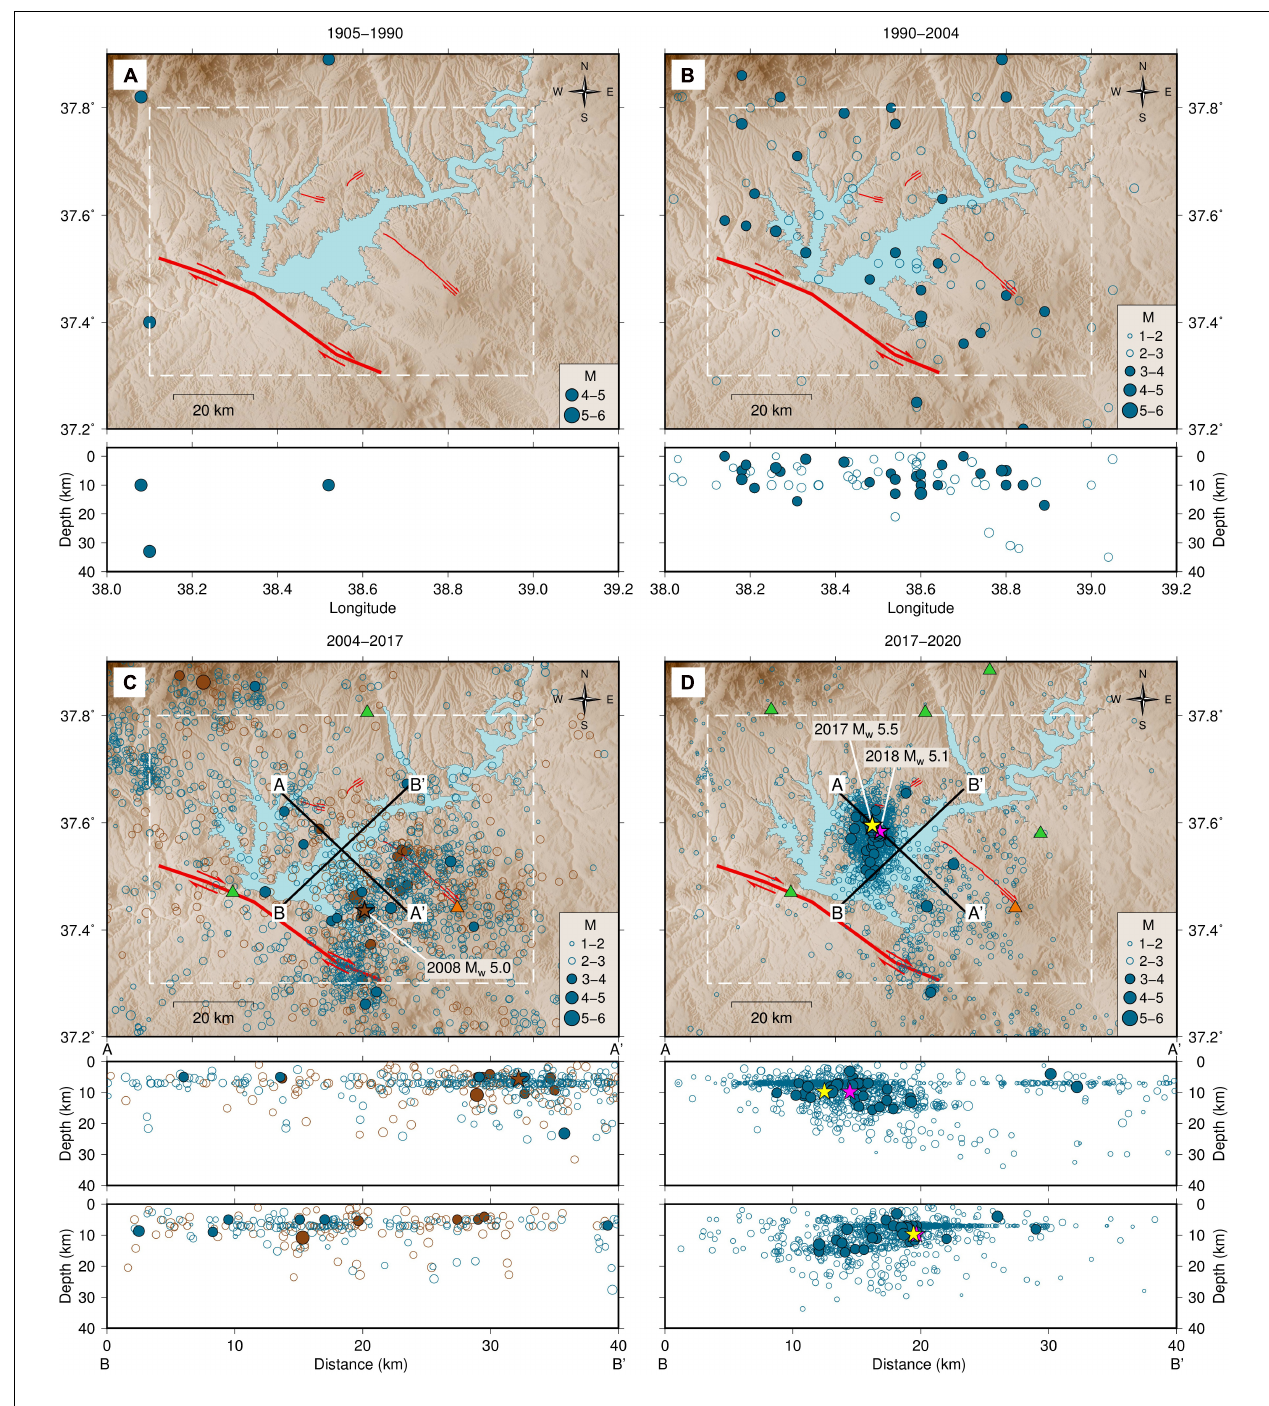
FIGURE 2 | (A–D) Long term (1905–2020) spatio-temporal evolution of recorded earthquakes with their magnitudes and depth cross-sections based on a joint KOERI-AFAD catalog near Atatürk Reservoir. The spatial earthquake distribution of historical and instrumental seismic activity around AR for (A ) the period 1905–1990 before the water filling, (B) 1990–2004 after the impoundment of the dam – depth versus longitude in panels (A–C) 2004–2017 and two orthogonal cross-sections crossing the dam (AA (cid:48) ,BB (cid:48) ) . The brown dots here show the events during 2004–2008 to highlight the background seismicity, the M w 5.0 2008 earthquake, and its aftershocks (D) 2017–2020, same cross sections as in panel (C) . The existing broadband seismic stations during the corresponding periods are marked by the green (AFAD stations) and orange (KOERI stations) triangles. Yellow and pink stars refer to the hypocenters of March 2, 2017, M w 5.5 and April 24, 2018, M w 5.1 earthquakes, respectively. The white dashed rectangle marks the region where the seismic catalogs are combined (37.3 ◦ -37.8 ◦ E, 38.1 ◦ -39.0 ◦ N). The red lines represent the Bozova, Samsat, Kalecik, and Lice Faults (see Figure 1 to detail).